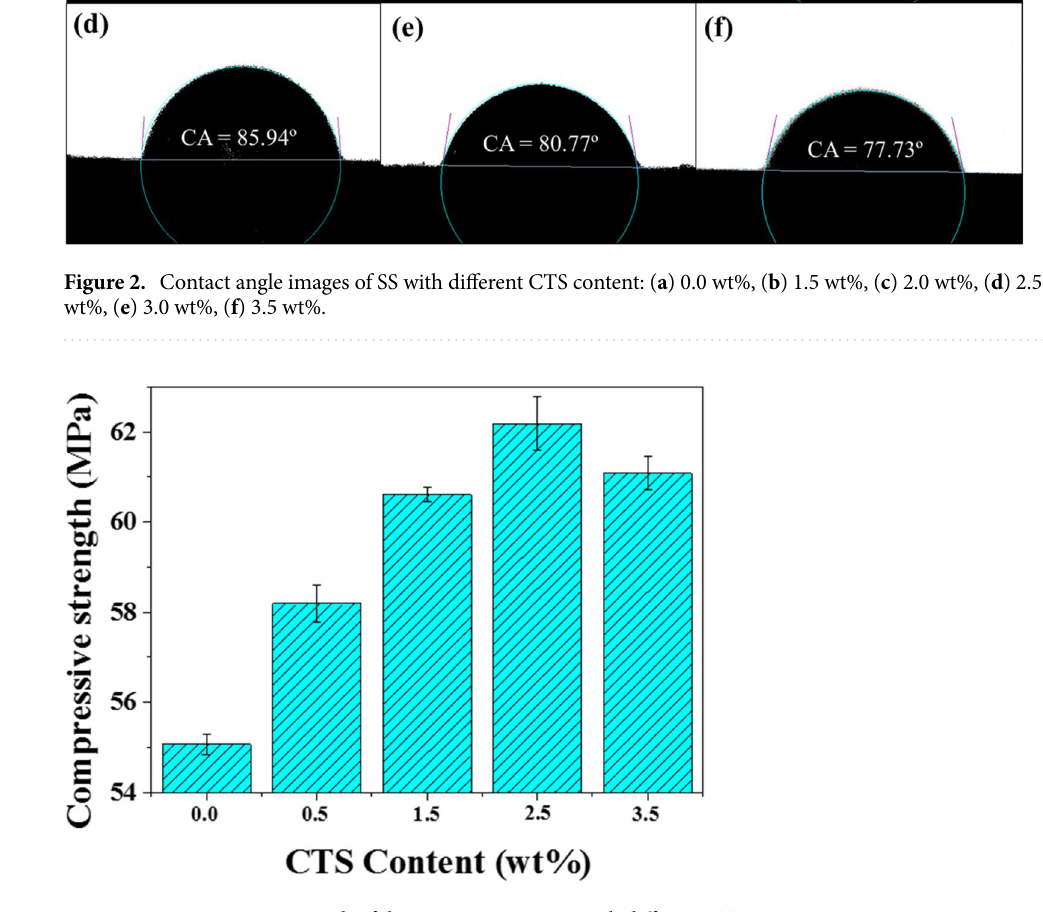
Figure 3. Compressive strength of the SS/PU composites with different CTS